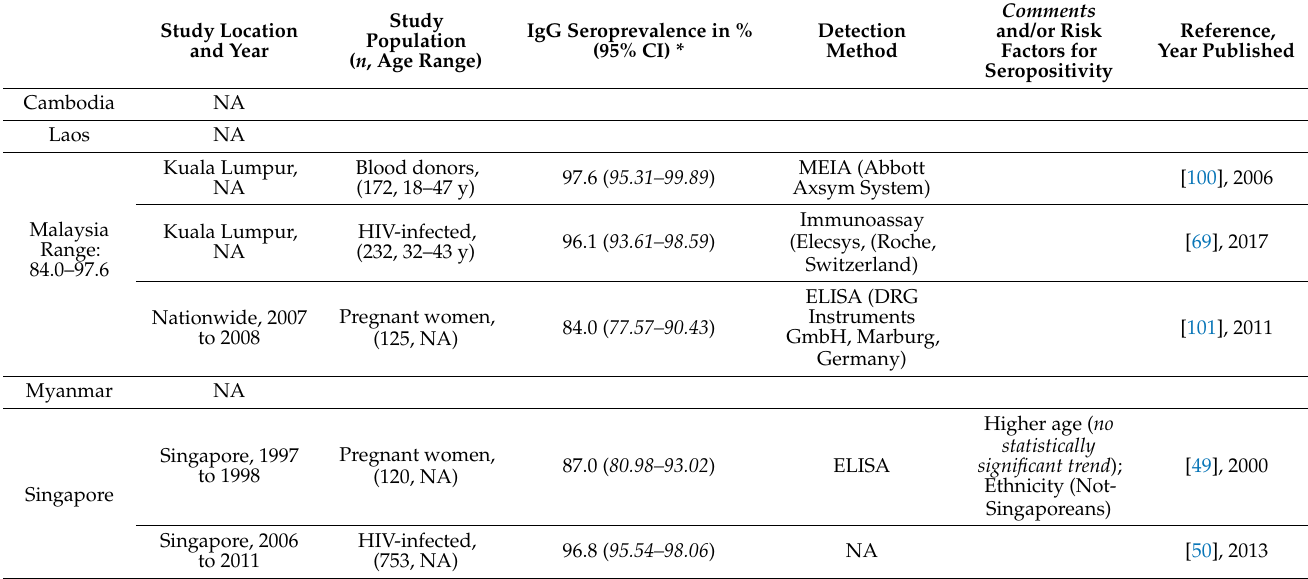
Table 6. CMV IgG serosurveys. * Only results on overall antibody seroprevalence (IgM + IgG) are available; Confi- dence Intervals (CI) in Italics estimated as described in Methods; EIA = Enzyme immunoassay; ELISA = Enzyme-linked Immunosorbent Assay; MEIA = Microparticle EIA; NA = not available; y =